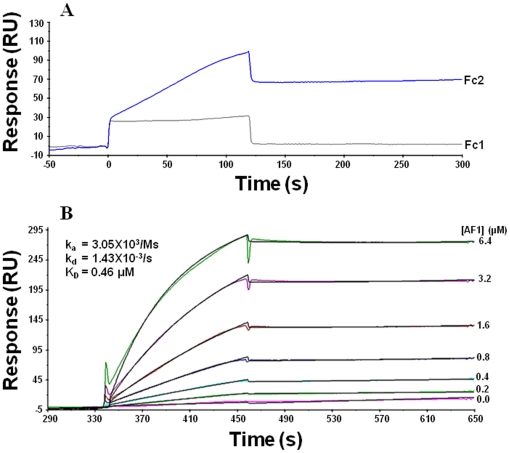
Analysis of the binding of the GR AF1 to TBP by SPR.TBP was immobilized to the Fc2 channel of C1 chip as the ligand, the Fc1 was equally treated but without TBP as the control channel. AF1 was used as the analyte to measure the binding as described in “Materials and methods”. A multi-cycle kinetics assay was run by Biacore X-100 plus. A) Raw sensorgrams of Fc1 and Fc2 to show the specific binding of AF1 to TBP. B) The adjusted sensorgrams (Fc2-Fc1) were overlaid and fitted for kinetics with 1∶1 binding model. The measured sensorgrams are shown in color, and the fitted ones in black. The experiments were repeated twice.